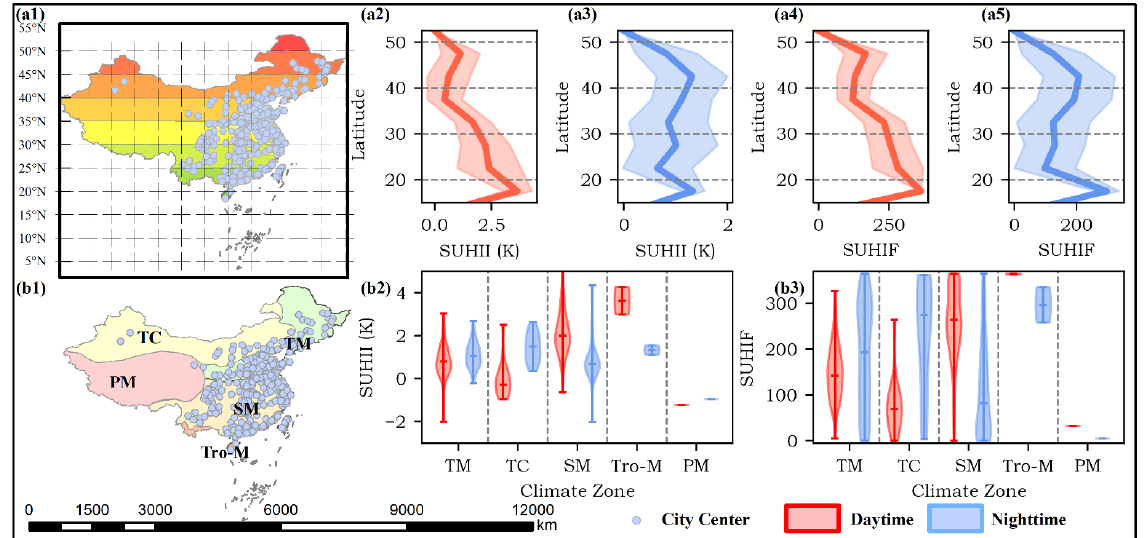
Figure 4. Latitudinal and climate zone-based variations of SUHII and SUHIF at daytime and nighttime. The two maps ( a1 , b1 ) show the latitudinal and climatic distributions of the selected cities, respectively. The plots in the first row show latitudinal variations of SUHII ( a2 , a3 ) and SUHIF ( a4 , a5 ) based on the combination of their average and variance. The violin plots in the second row show climate zone-based variations of SUHII ( b2 ) and SUHIF ( b3 ). The daytime and nighttime patterns are represented based on red and blue colors,